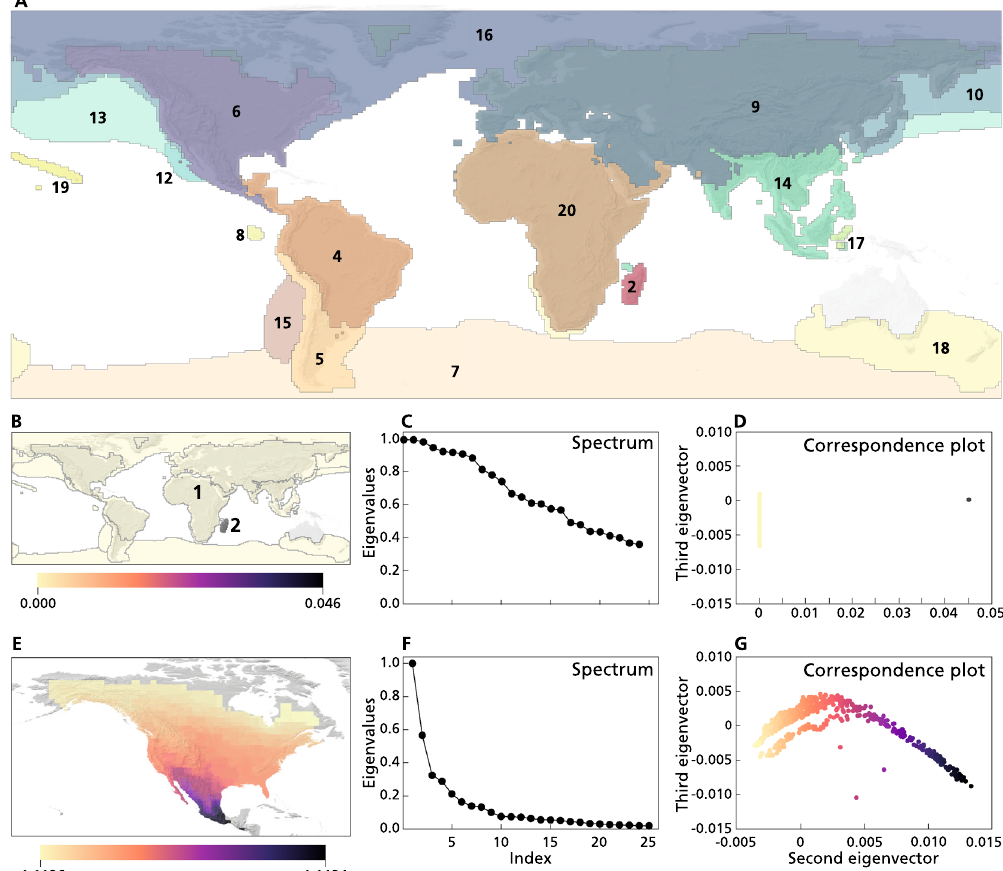
Figure 2. Applying CA to ecological data: the global geographical distribution of the Carnivora mammalian order. Panel (A) : Map showing the spatial distribution of the clusters (i.e., bioregions) resulting from application of our heuristic approach to CA. The numbers indicate the resulting clusters. The first split separates Madagascar (2) from the rest of the world (1) (see also panel B ). The rest of the world cluster is subsequently split into non-nested clusters, of which one is further split into clusters 12 and 13. Panel (B) : Spatial distribution of the coefficients in the first CA axis when all data is considered. Madagascar is colored in red (2) and the rest of the world in blue (1). Panel (C) : Sorted spectrum for all data, showing two eigenvectors with value equal 1, indicating that there are two fully disconnected clusters. Panel (D) : Correspondence plot of first and second CA axes (i.e., 2nd and 3rd eigenvector). Colors indicate the first axis, corresponding to colors in panel (B) . The first axis separates the two clusters, but does not show variation within clusters. Panel (E) : Spatial distribution of the coefficients in the second eigenvector for the subcluster 6 corresponding to the Nearctic bioregion, in North America. The eigengap is found between the first and second eigenvalues, suggesting that the network does not contain any subclusters (F) . Panel (G) : The correspondence plot for the first and second CA axes, colored according to panel (E) , showing how the first axis separates sites along a clear latitudinal gradient. This analysis was performed using our SCCA R package. Maps were produced with Qgis https:// qgis.